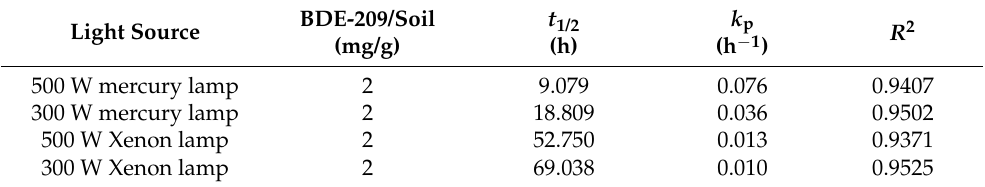
Table 2. BDE-209 photolysis kinetic parameters with different light sources.